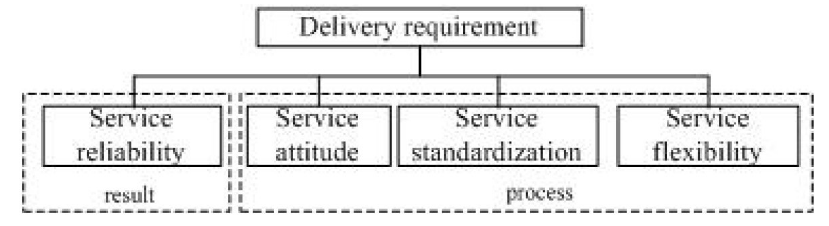
Figure 2. Classification of service requirement